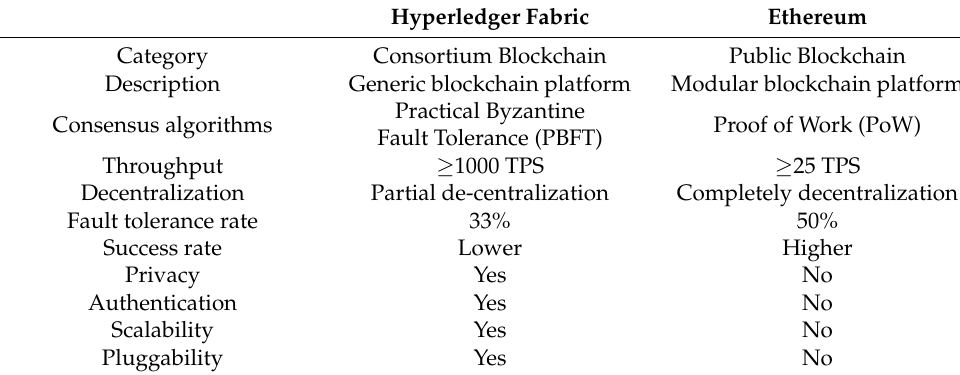
Table 6. Comparison between Ethereum and Hyperledger Fabric.